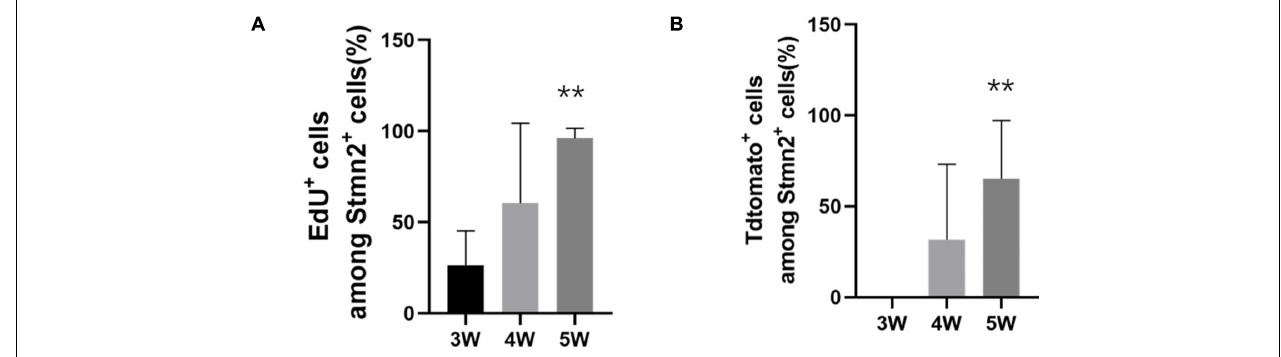
FIGURE 8 | The quantification of proliferation of the neuronal stem-like cells. (A) The quantification of the percentage of EdU + cells among all Stmn2 + cells in the sciatic nerve. Values represent mean ± SEM ( n = 5 sciatic nerves for each time point; ** p < 0.05; one-way ANOVA with Dunnett’s multiple comparisons test). (B) Quantification of the proportion of TdTomato + cells among all Stmn2 + cells in the sciatic nerve. Values represent mean ± SEM ( n = 5 sciatic nerves for each time point; ** p < 0.05; one-way ANOVA with Dunnett’s multiple comparisons